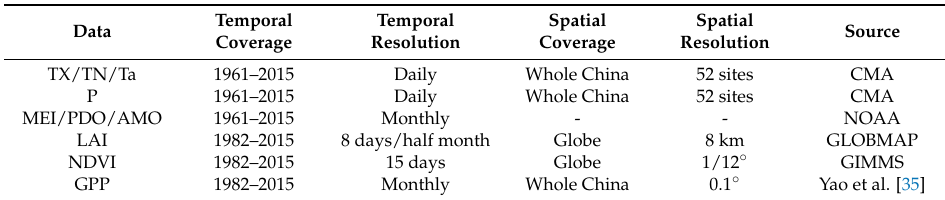
Table 1. Summary of the data used in this study.